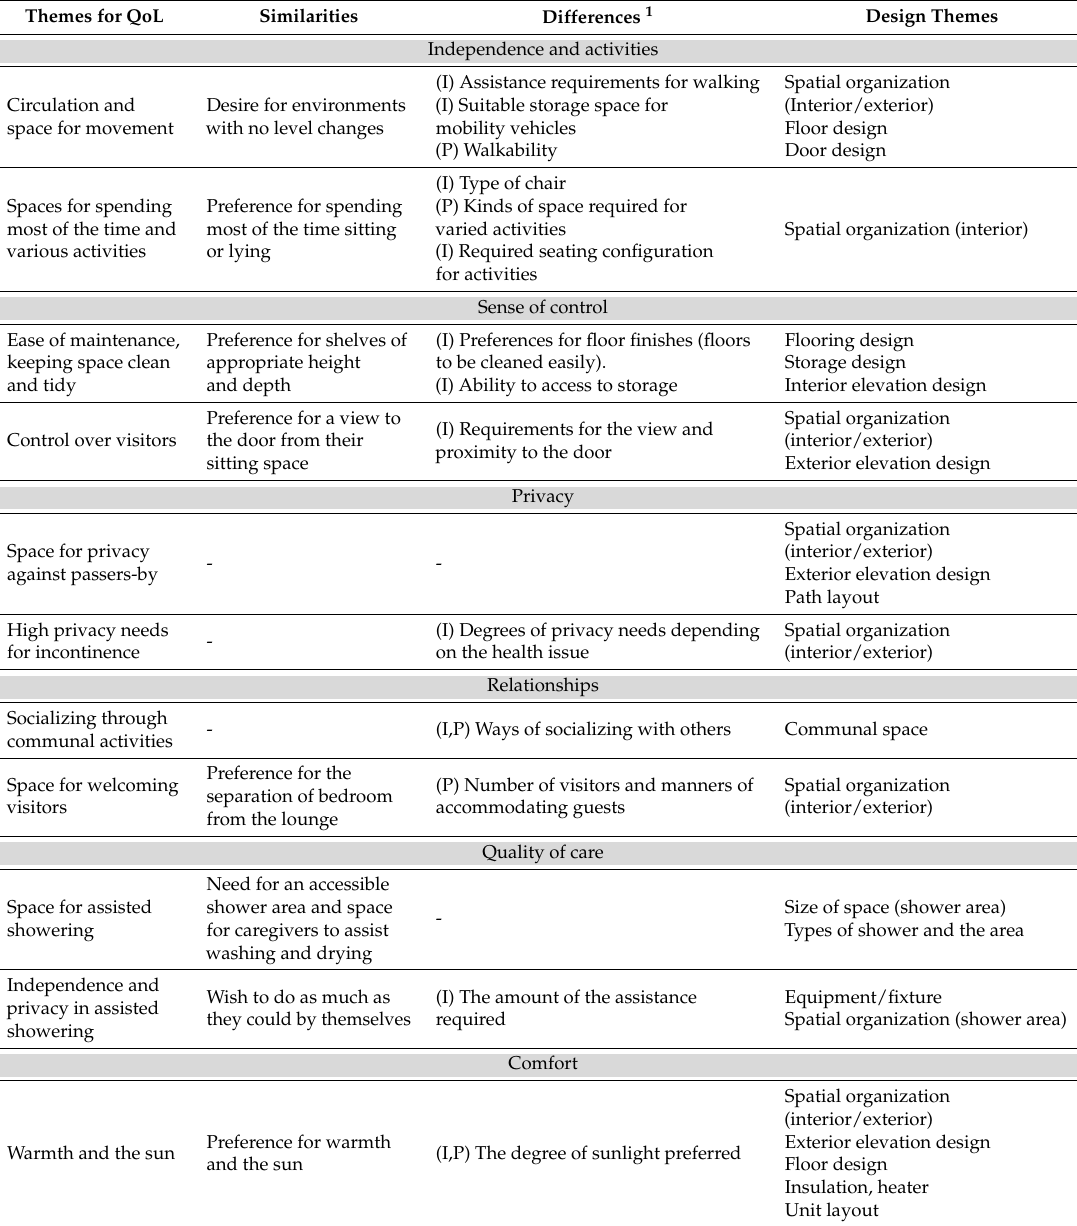
Table 2. Analysis of themes for Quality of Life (QoL) and relevant design